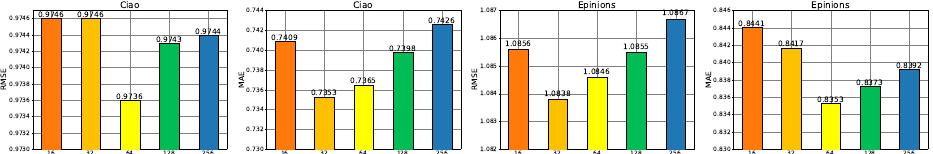
Figure 4. The performance comparison of the different embedding dimensions K of this model on the Ciao and Epinions datasets.